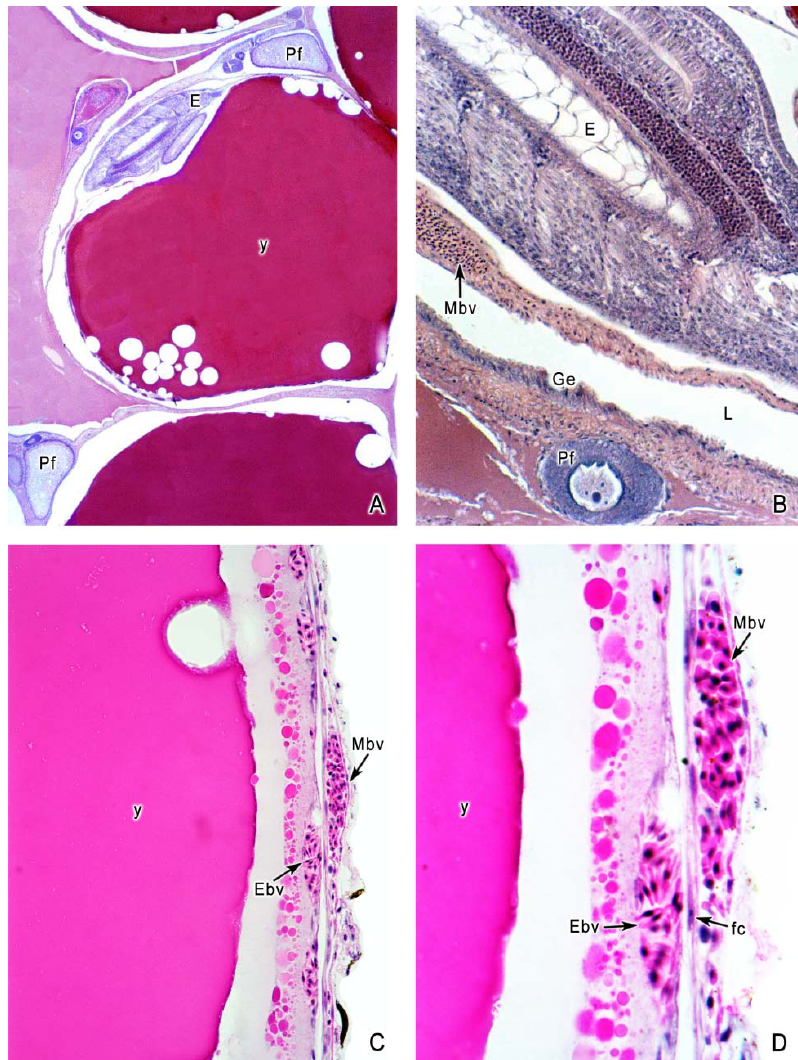
Figure 6. Ovaries during early intrafollicular embryogenesis and follicular placenta. ( A ) Ovary of Xiphophorus helleri with an embryo (E) during early development; the fluid yolk (y) is abundant. Previtellogenic oocytes (Pf) are also seen. 200×. ( B ) Detail of the previous figure with the embryo (E). A maternal blood vessel (Mbv) near the embryo is seen. The ovarian wall shows a previtellogenic follicle (Pf) with basophilic ooplasm. The germinal epithelium (Ge) borders the lumen (L). 500×. ( C ) Periphery of an embryo of Gambusia affinis at the ventral side where the yolk is seen (y). The essential components of the follicular placenta, the maternal (Mbv) and embryonic (Ebv) blood vessels, are closely positioned. 200×. ( D ) Detail of the previous figure with the evident close position of the maternal (Mbv) and embryonic (Ebv) blood vessels; follicular cells (fc) between them form a squamous epithelium. 500×.